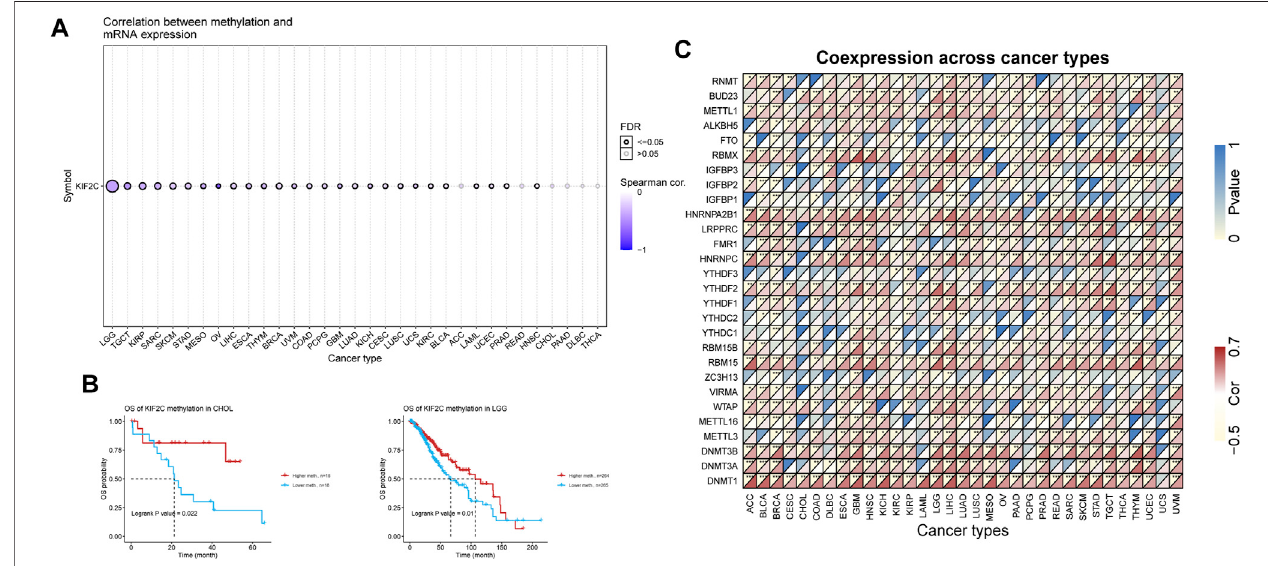
FIGURE 4 | Epigenetic analysis of KIF2C. (A) Correlation of KIF2C methylation with mRNA expression. (B) Prognostic analysis of KIF2C methylation in CHOL and LGG. (C) Heatmap of the correlation between KIF2C and transmethylase genes, m6A-related genes and m7G-related genes in